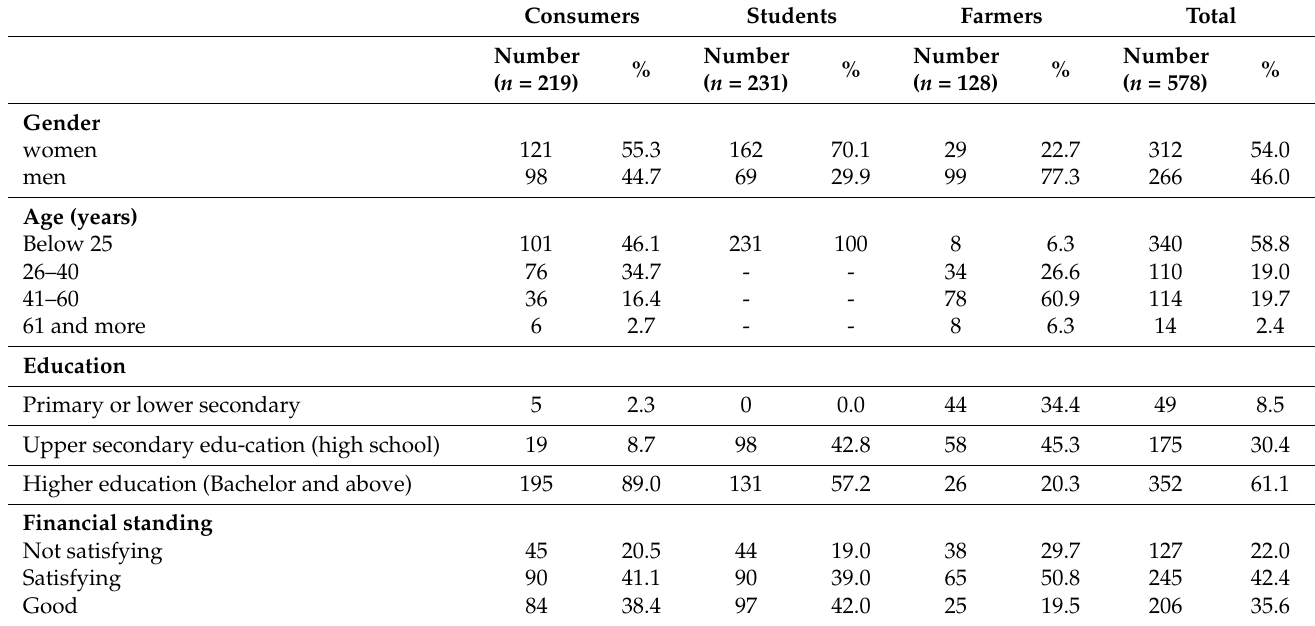
Table 1. Demographic characteristics of the sample of